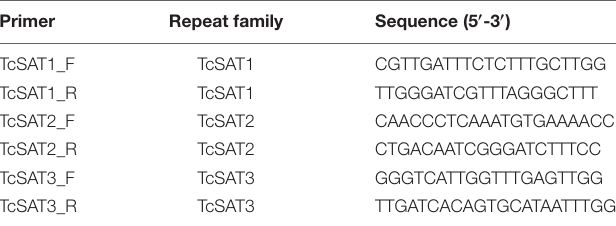
TABLE 2 | Primer sequences for amplification of tandem repeat specific